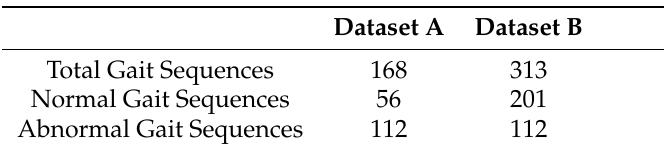
Table 3. Dataset partitions used for this